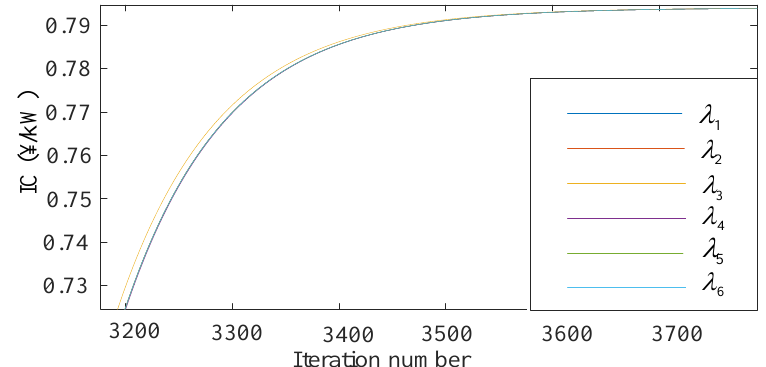
Figure 5. The incremental cost (IC) of each customer with neighbor interconnection.